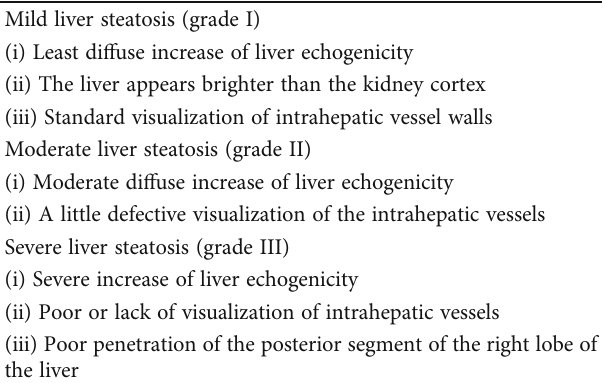
Table 1: Grading of nonalcoholic fatty liver on ultrasonography.